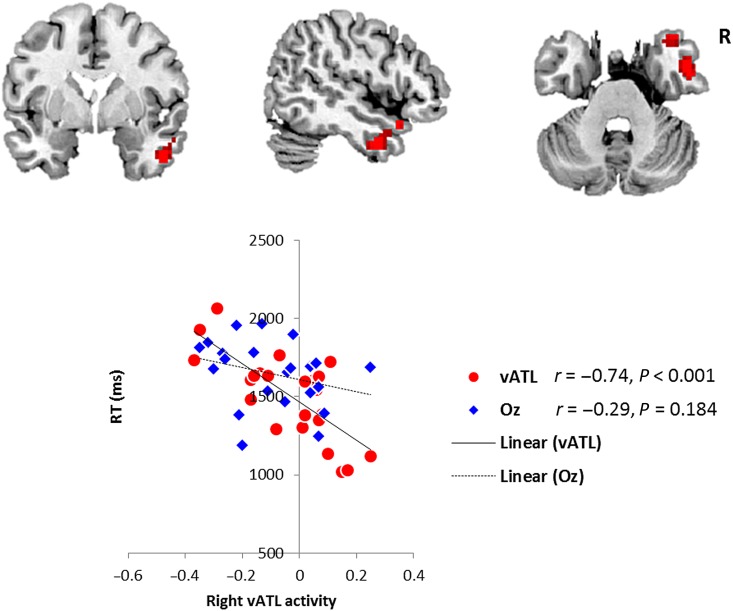
Right vATL activity predicted semantic RT after cTBS over the left vATL (top). Scatter plot shows the behavioral correlation in the right vATL following cTBS to either the left vATL or the control (Oz) site (bottom). Red circles represent semantically related individual activity in the right vATL after left vATL stimulation. Blue diamonds represent the same right vATL activation-behavioral correlations (nonsignificant) after control stimulation.